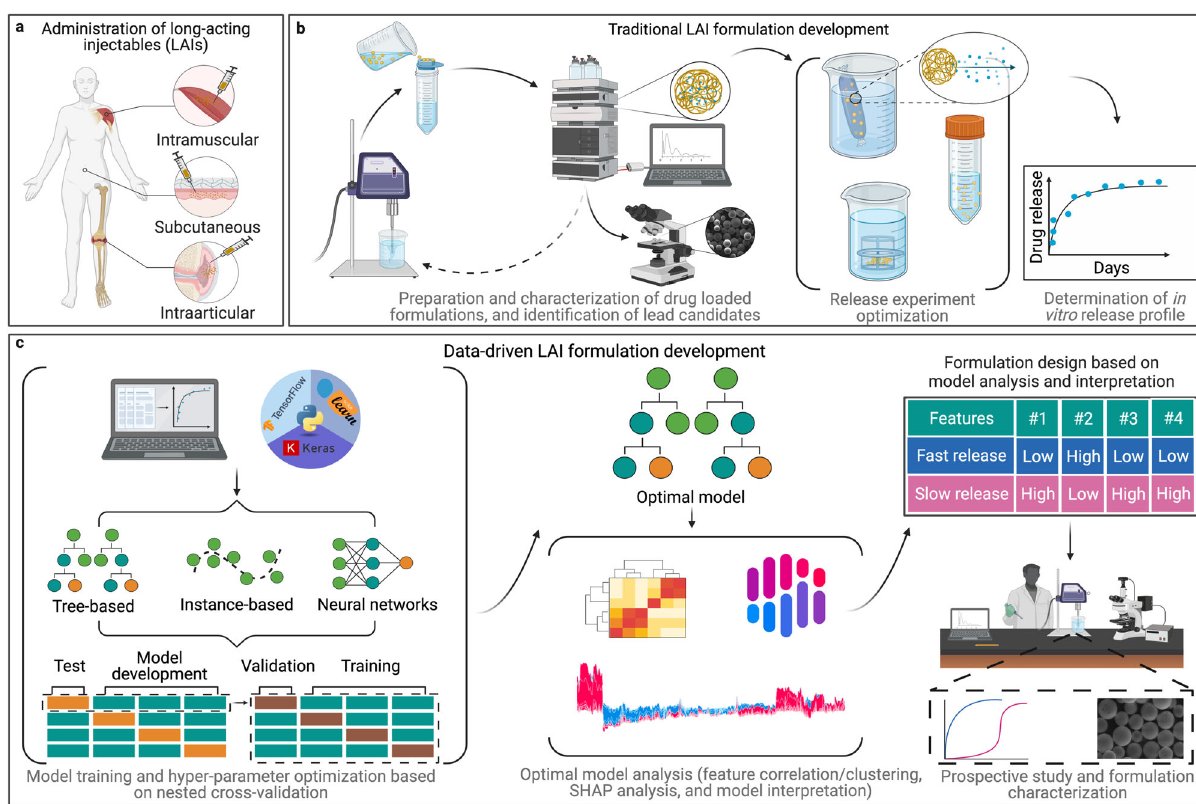
Fig. 1 | Schematic demonstrating traditional and data-driven formulation developmentapproachesforlong-actinginjectables(LAIs).a Selectedroutesof administration for FDA-approved LAI formulations. b Typical trial-and-error loop commonly employed during the development of LAIs termed “ traditional LAI